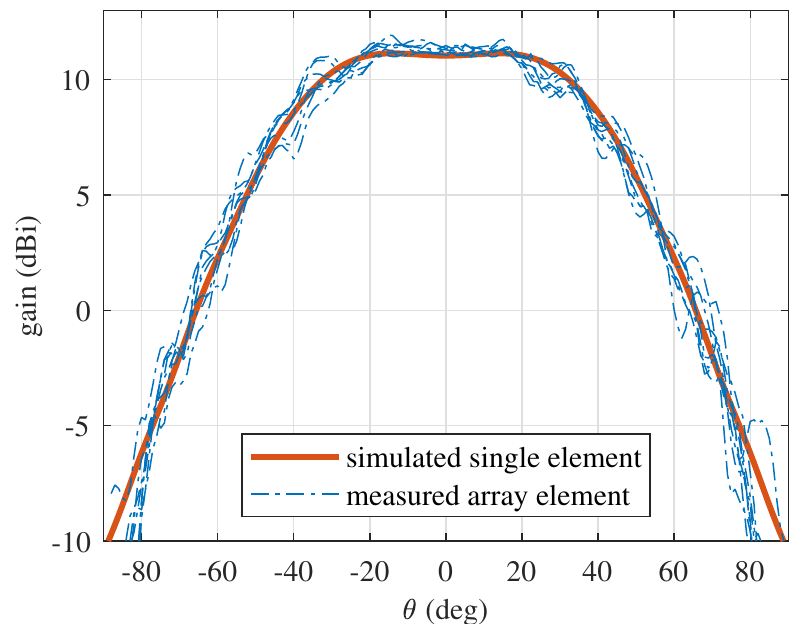
Figure 15. Measured radiation patterns of each antenna element when the array is configured as an irregular array. The simulated single element, when considering an infinite ground plane, is overlaid. A measurement of the gain was not taken, but each pattern was normalized to the simulated gain at θ = 0 ◦ .